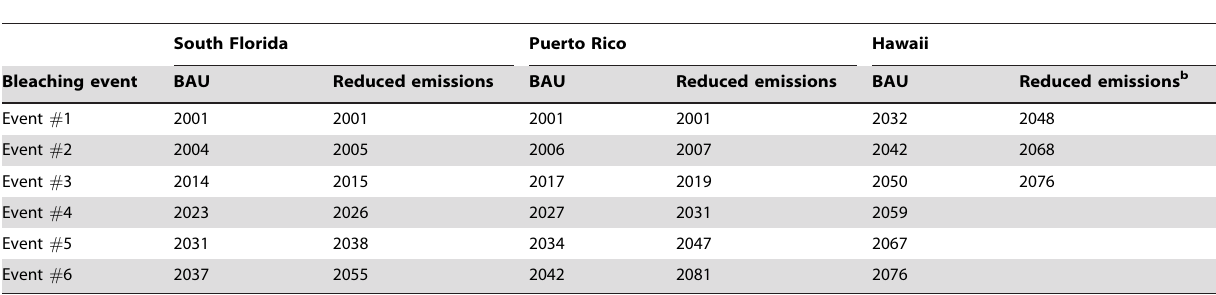
Table 5. Timing of six modeled bleaching events in each location a